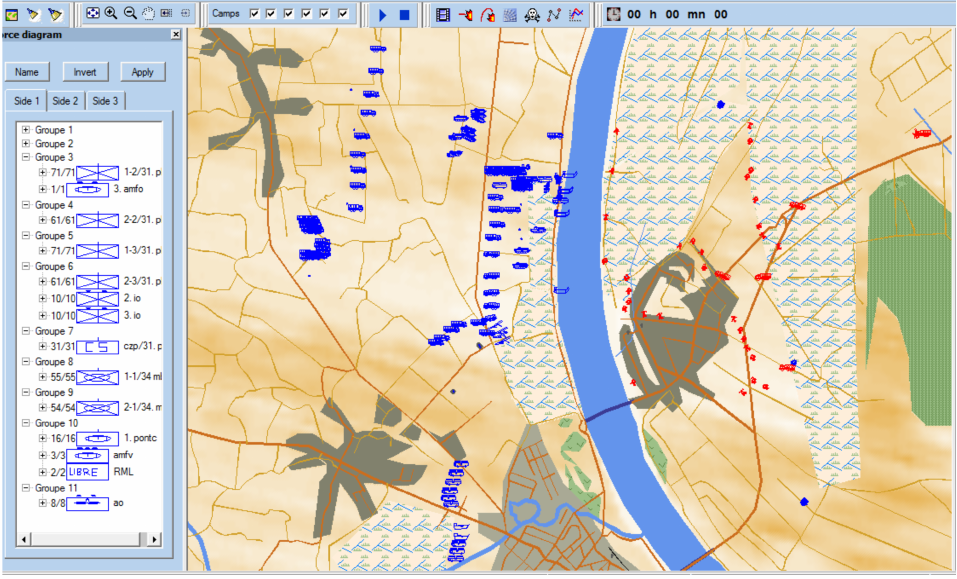
Figure 5. Overview of the simulation start for the alternative